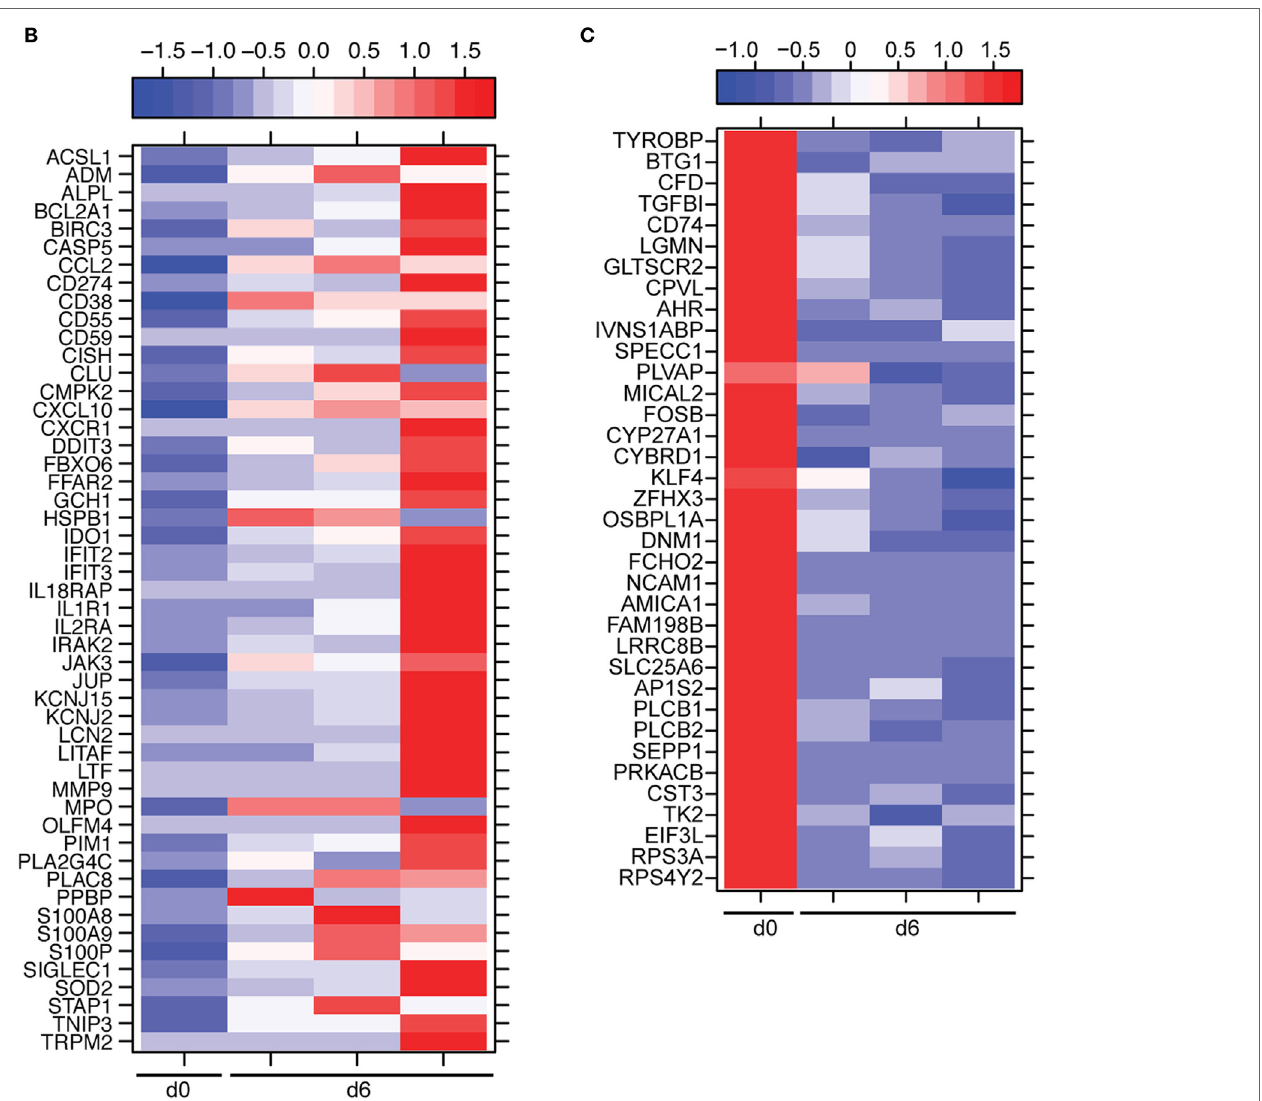
FigUre 3 | Monocytes contribute significantly to ZEBOV-associated inflammation. (a) Network showing direct interactions between differentially expressed genes (DEGs) upregulated 6 DPI in monocytes that enriched to “Immune system process.” (B) Heatmap representing gene expression (shown as absolute normalized RPKM values) of DEGs upregulated 6 DPI that enriched to “Regulation of programmed cell death” and “Response to oxygen containing compound” with a fold change ≥ 10.5; range of colors is based on scaled and centered RPKM values of the entire set of genes (red represents increased expression while blue represents decreased expression); day 0 is represented by the median RPKM value, while each column represents 1 animal for 6 DPI. (c) Heatmap representing gene expression (shown as absolute normalized RPKM values) of all downregulated genes 6 DPI; range of colors is based on scaled and centered RPKM values of the entire set of genes (red represents increased expression while blue represents decreased expression); day 0 is represented by the median RPKM value, while each column represents 1 animal for 6